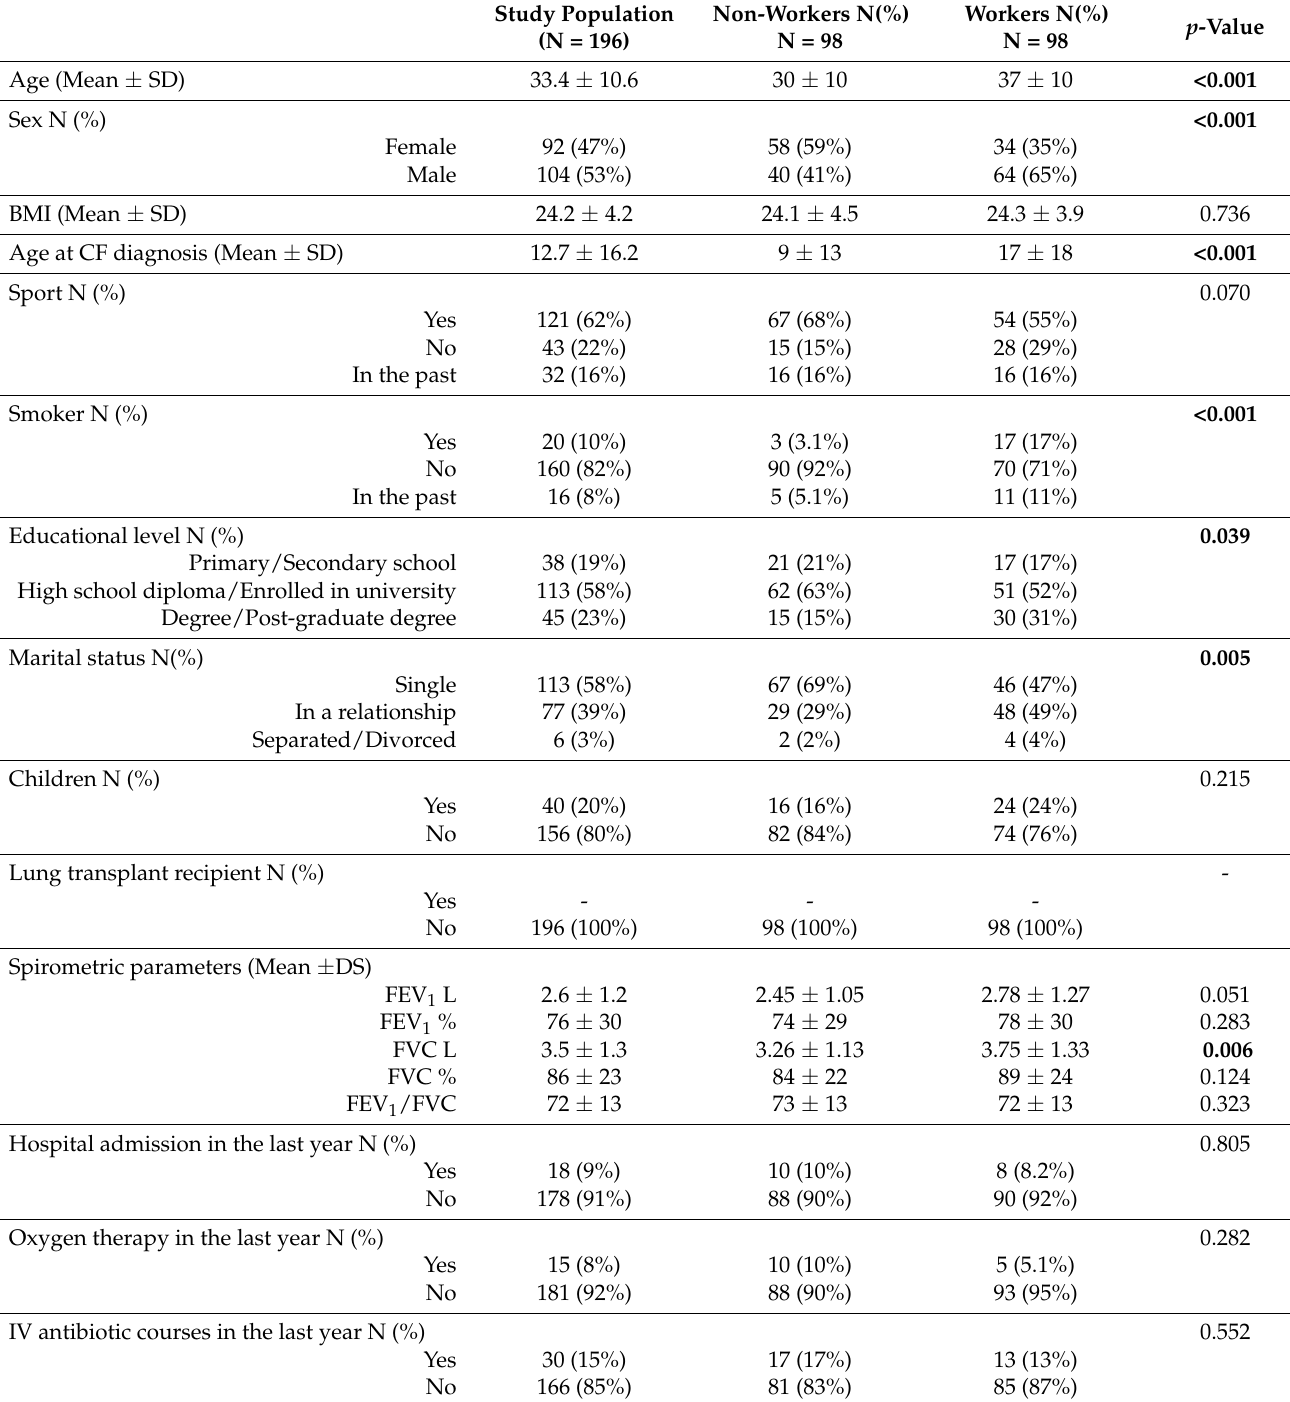
Table 1. Characteristics of the study participants and differences between working and non-working subjects. Data are presented as frequency (percentages) for categorical data and as M ± SD for continuous data. p -values referring to working vs. non-working subjects are computed with chi-square or Fisher test as appropriate for categorical data or with Student’s t test or Mann–Whitney U test as appropriate for continuous data. Significant values are marked in